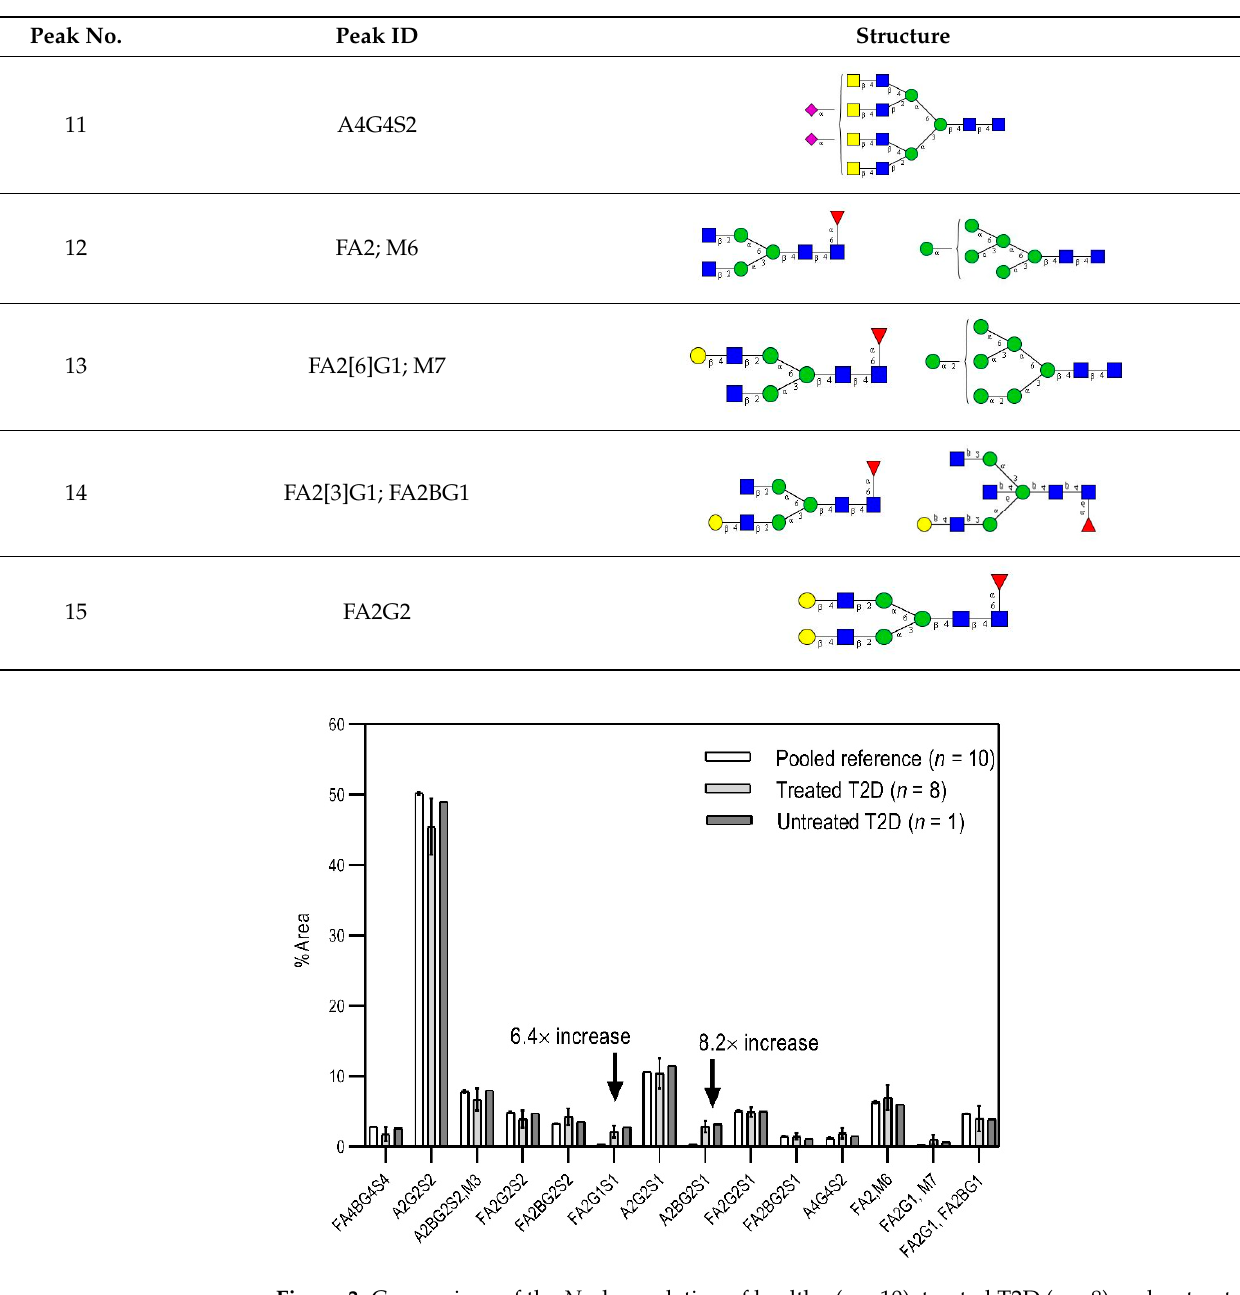
Figure 3. Comparison of the N -glycosylation of healthy ( n = 10), treated T2D ( n = 8) and untreated T2D ( n = 1) blood samples. Separation conditions were the same as in Figure 1.